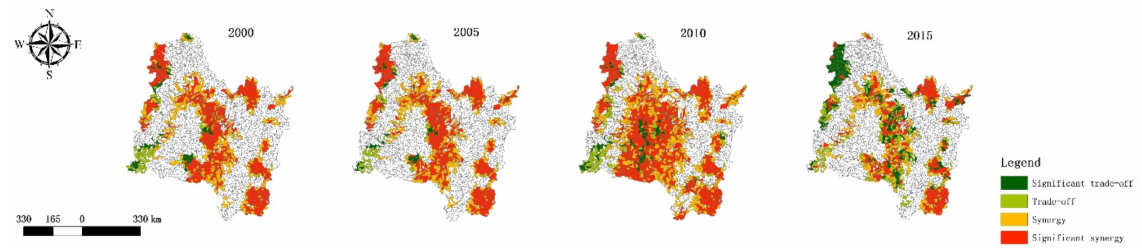
Figure 11. The synergy/trade-off relationship between water retention and biodiversity. The synergy/trade-off relationship between the water retention and carbon